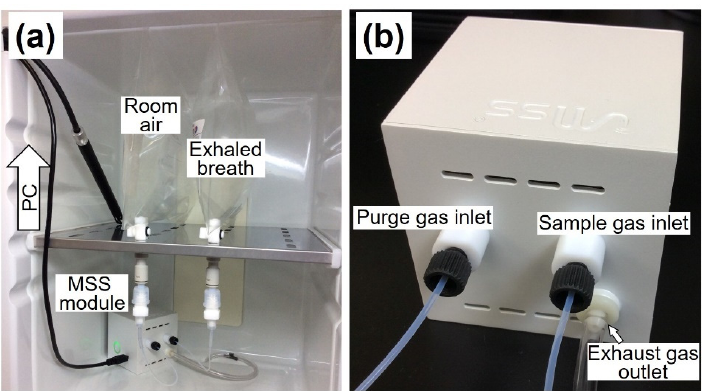
Figure 3. ( a ) Measurement setup for gas samples with the MSS measurement module. The module